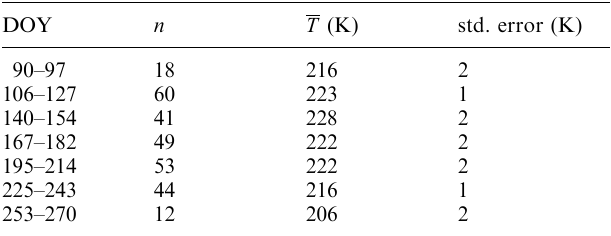
Table 5. The duration of each campaign, number of spectra ( n ), mean temperature and standard error in the mean. DOY